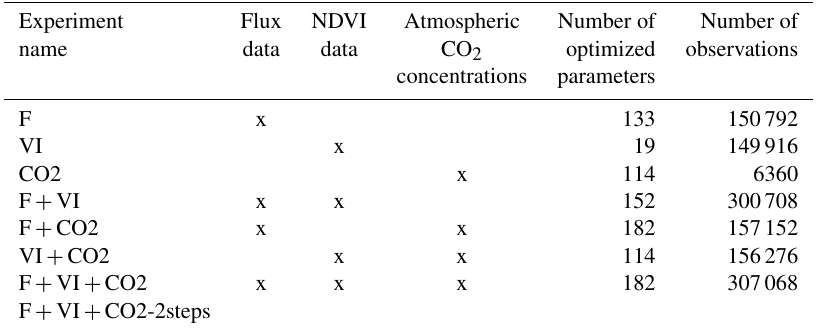
Table 2. Characteristics of the various assimilation experiments (flux data – F, satellite NDVI vegetation index – VI and atmospheric CO 2 concentration –